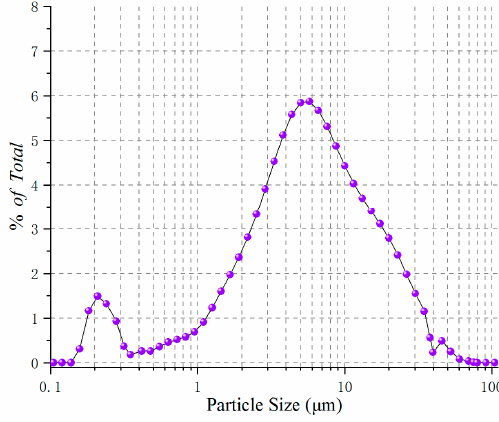
Figure 9. Particle size distribution.